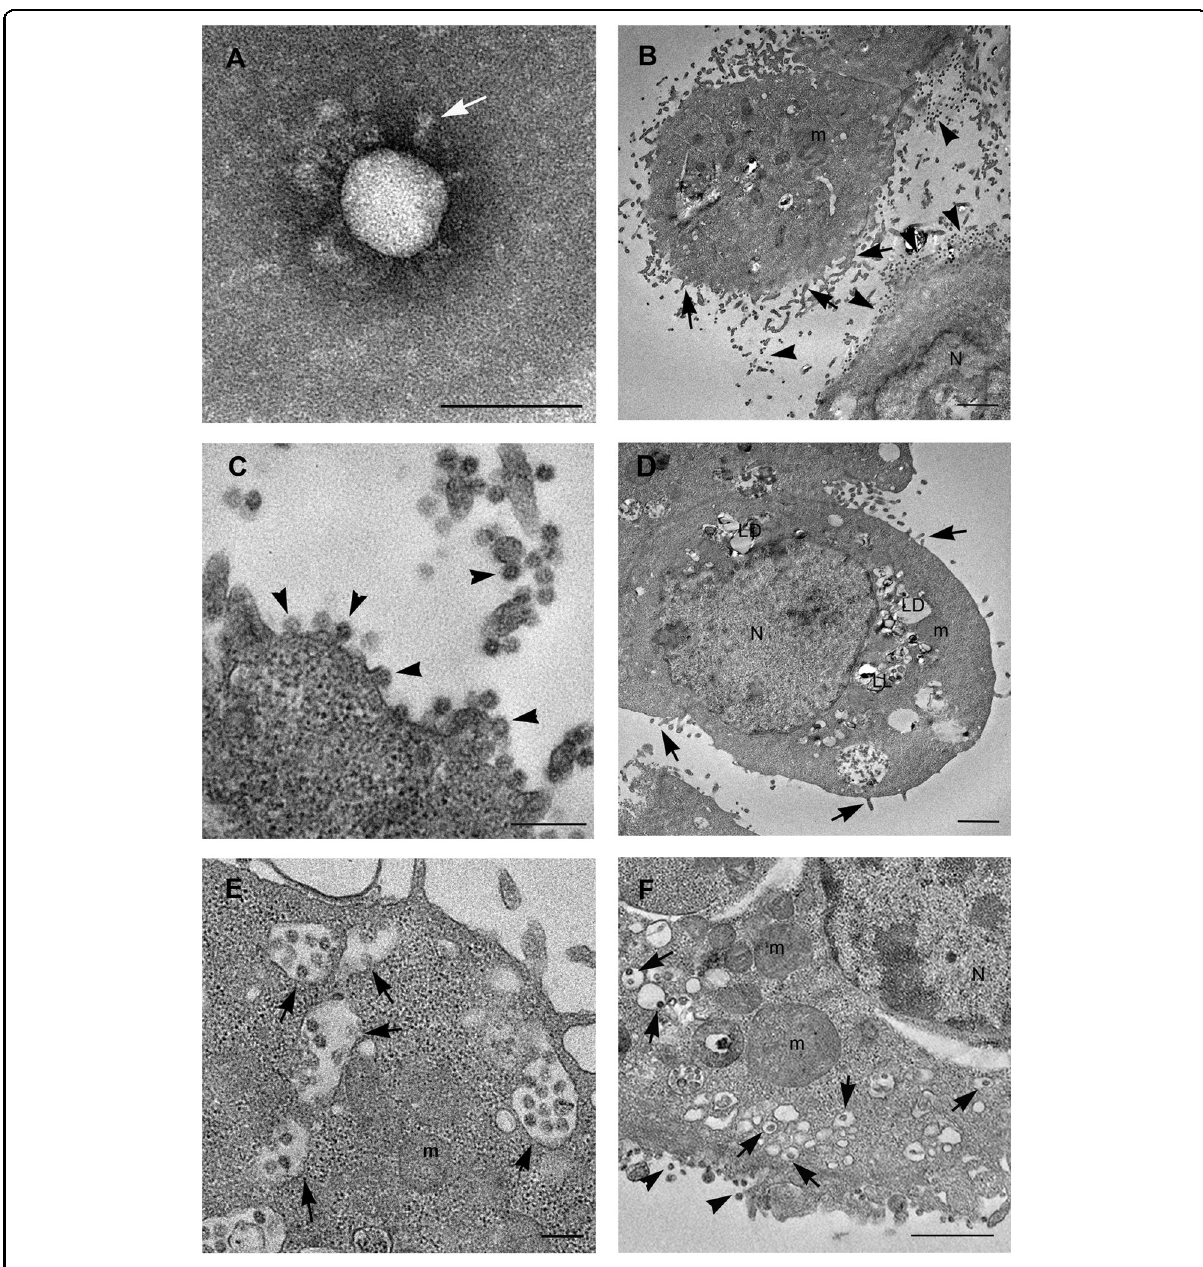
Fig. 1 Electron microscopy images of SARS-CoV-2 virus and infected Vero cells. A Negative staining electron microscopy micrographs of SARS- CoV-2 particle. The virion display a spherical shape, on the surface cone-like shaped spikes are visible (white arrow). B – D Infected cells show numerous viruses associated to the plasma membrane (arrowheads) especially found along microvillous projections (arrows). Many lipid droplets (LD) and lipolysosomes (LL) are visible ( D ). E A great number of vacuoles are present in the cell cytoplasm, many of which contain viral particles (arrows). F Other vesicles, small in size, contain single viral particles, resembled the “ spherules ” described for other coronaviruses (arrows). Viruses are visible along the plasma membrane (arrowheads). Numerous free ribosomes are diffused in the cell cytosol. N nucleus, m mitochondria, LD lipid droplets, LL lipolysosomes. Scale bars: A = 100 nm; B , D , F = 1 μ m; C , E = 200